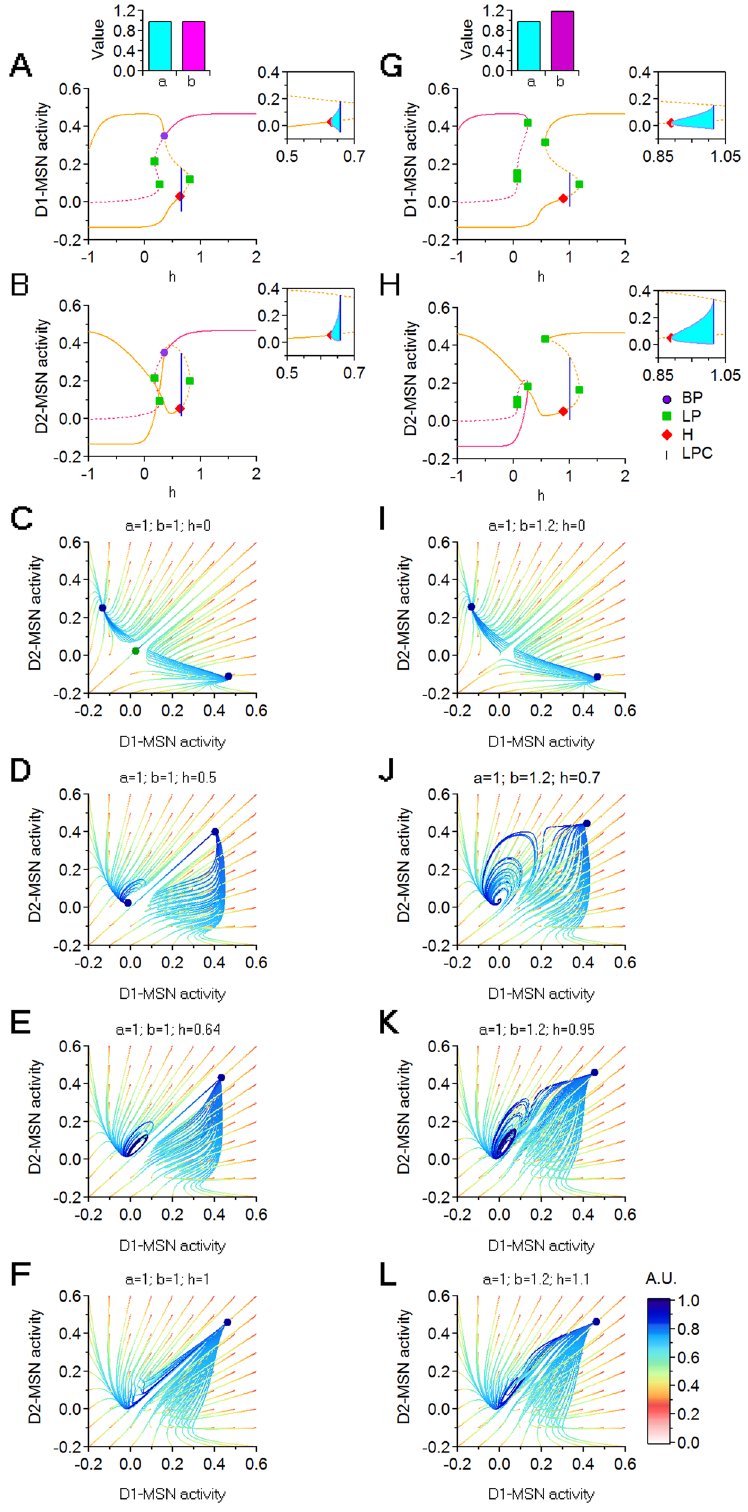
Figure 10. Dynamic transitions for ( a = 1, b = 1) and ( a = 1, b = 1.2). ( A , B ) Bifurcations with respect to h , for D1- and D2-MSNs. ( C – F ) Trajectories in a ( D 1, D 2) phase space slice for (top to bottom): h = 0; h = 0.5; h = 0.64; h = 1. ( G , H ) Bifurcations with respect to h , for D1- and D2-MSNs. ( I – L ) Trajectories in a ( D 1, D 2) phase space slice for (top to bottom): h = 0; h = 0.7; h = 0.95; h = 1.1. Fixed